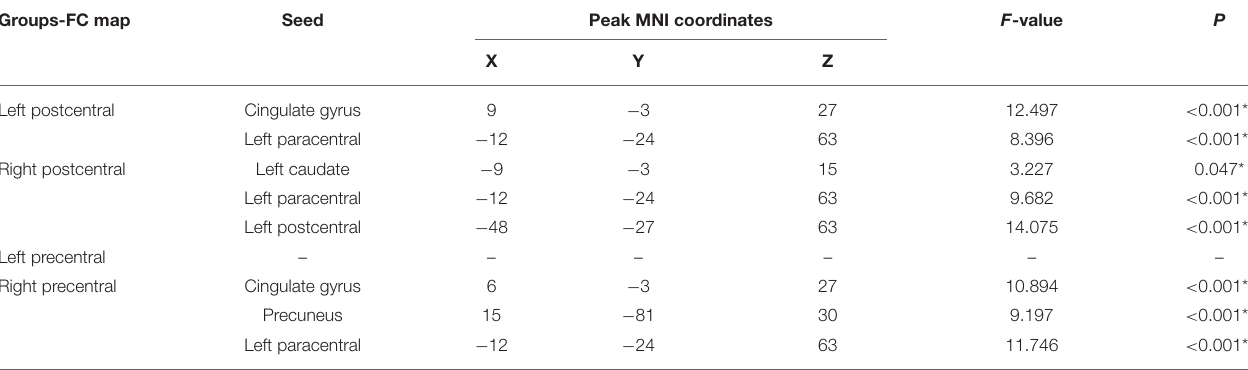
TABLE 4 | Differences in Desikan-Killiany-seed-based FC among LCSP, RCSP, and HC. Groups-FC